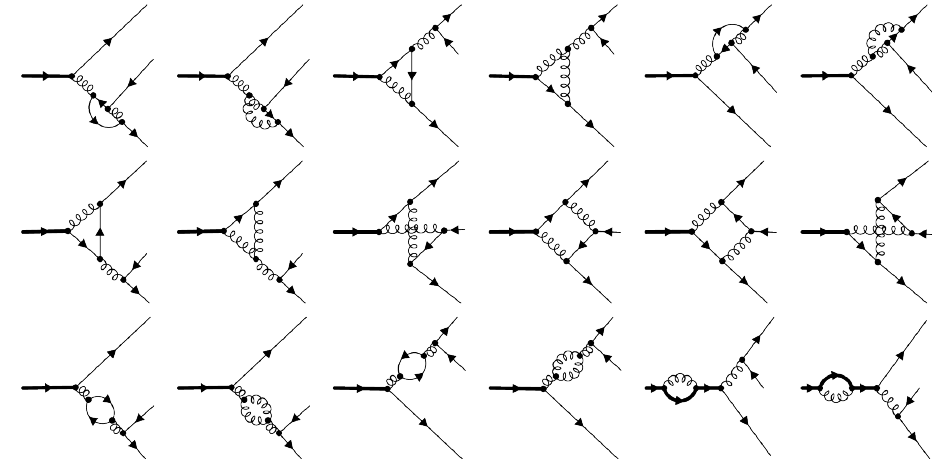
Figure 2 . 18 diagrams contributing to the splitting operator q → qq ¯ q . Description as in figure 1.